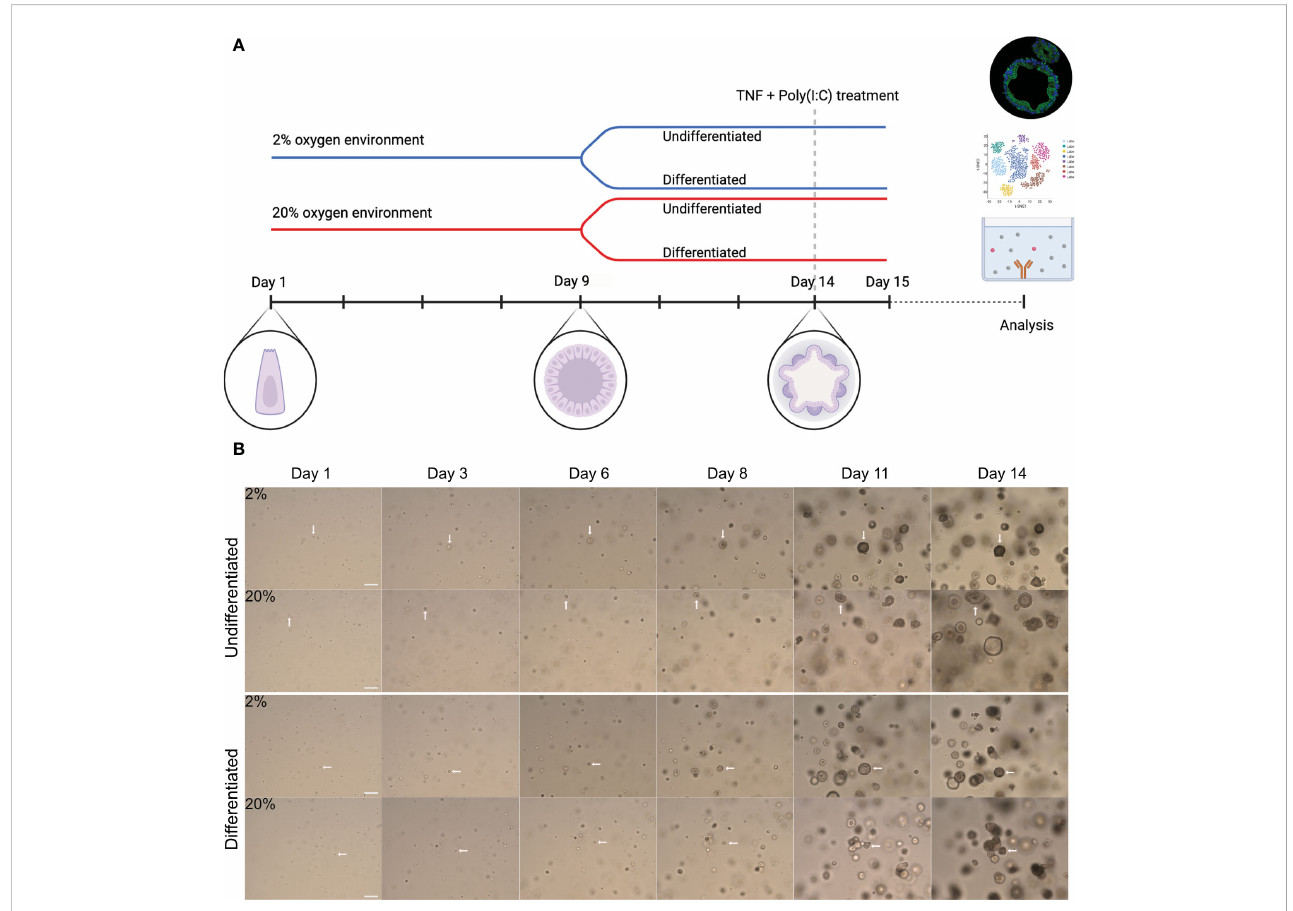
FIGURE 1 Experimental overview and growth of colonoids cultured in high and low oxygen. (A) General graphic representation of the experimental design. Colonoids were dissociated into single cells before plated at a density of 8000-10000 cells/50 ml matrigel and cultured in parallel in two incubators with 2% or 20% oxygen. Complete growth medium (CGM) was added every other day from establishment until 9 days, including ROCK inhibitor Y-27632 for the fi rst two changes. On day nine (unless speci fi ed otherwise), cell differentiation was induced in half of the wells by replacing CGM with differentiation medium, while the other half continued with CGM. The colonoids were kept in culture until day 14 unless they were treated with pro-in fl ammatory TNF + poly(I:C). The blue line represents colonoids cultured in a 2% oxygen environment, while the red line represents cultivation in a 20% oxygen environment. As illustrated, stem cells began as single cells, proliferated into spheroids, and ultimately differentiated into 3D structured colonoids with crypts and a central lumen. For the stimulation assays, the colonoids were cultured as described until day 14. Subsequently, they were treated with TNF + poly(I:C) for 24 hours before the material (RNA and conditioned medium) was collected. (B) Representative bright fi eld images (10x magni fi cation, EVOS microscope) of colonoid growth. The four image rows represent the four different conditions (undifferentiated or differentiated in 2% and 20%) cultured in parallel. The day the image was captured is indicated above the images. The white arrows follow a cell from a single cell to a 3D colonoid. Scale bar = 100 m